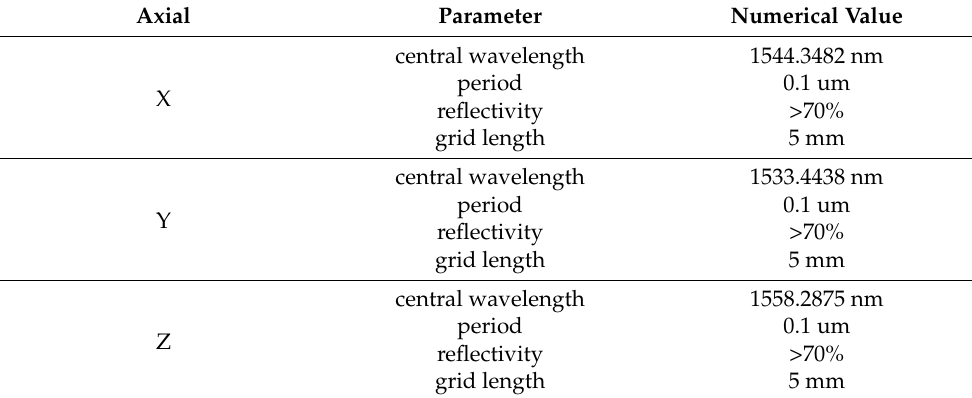
Table 2. Initial parameters of FBGs.